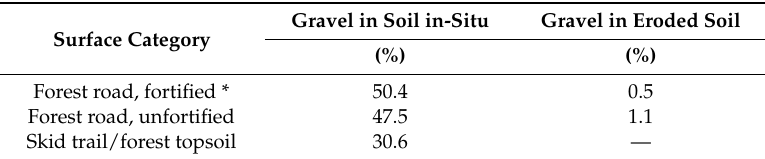
Table 10. Percentage of Gravel in in-situ and eroded soil for different surface categories.